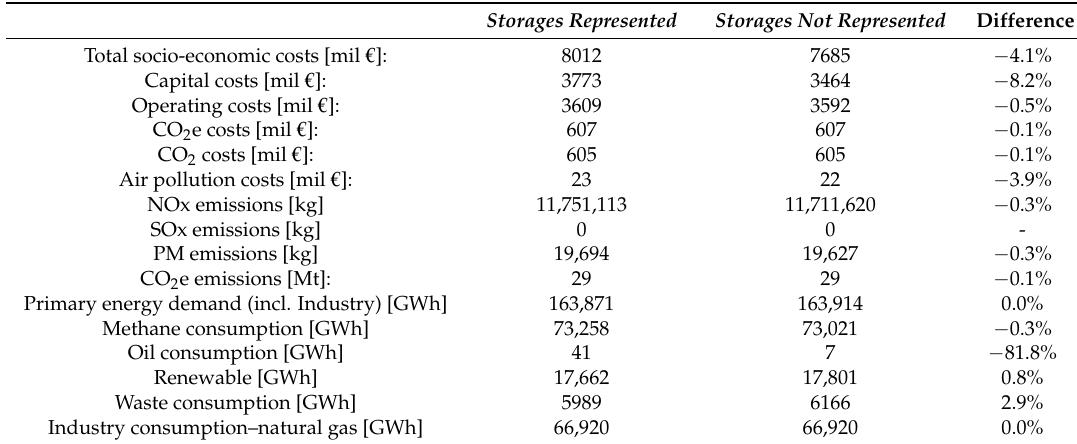
Table 3. Results of the comparison of energy models with and without large-scale storage representation ( Storages represented optimization run and Storages not represented run had all the predefined technologies the same, except that storage capacities were constrained to zero in the case of Storages not represented